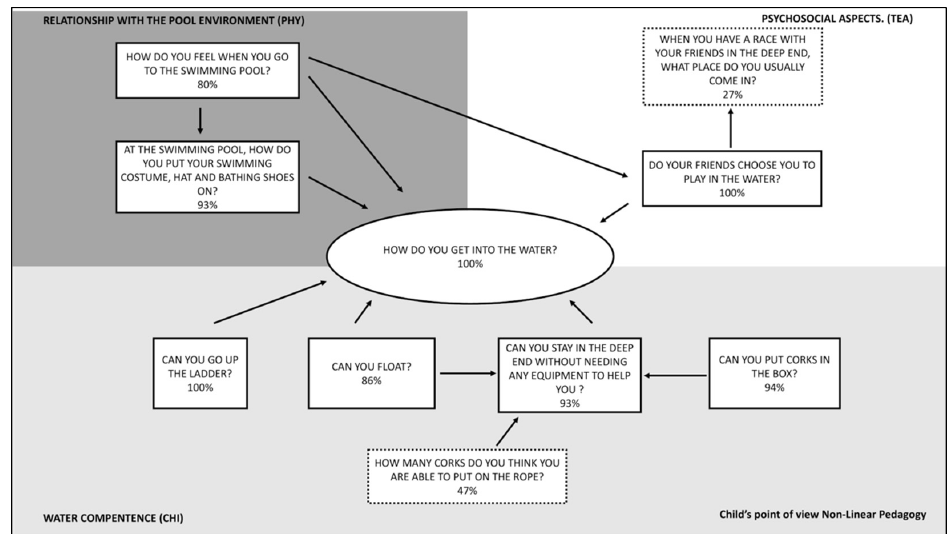
Figure 5. Diagram related to the perception of the children of the NL group according to the results of the pictorial scale indicating the percentage of positive responses.